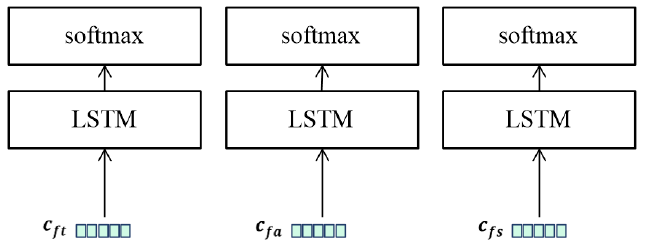
Figure 8. Framework of task-specific